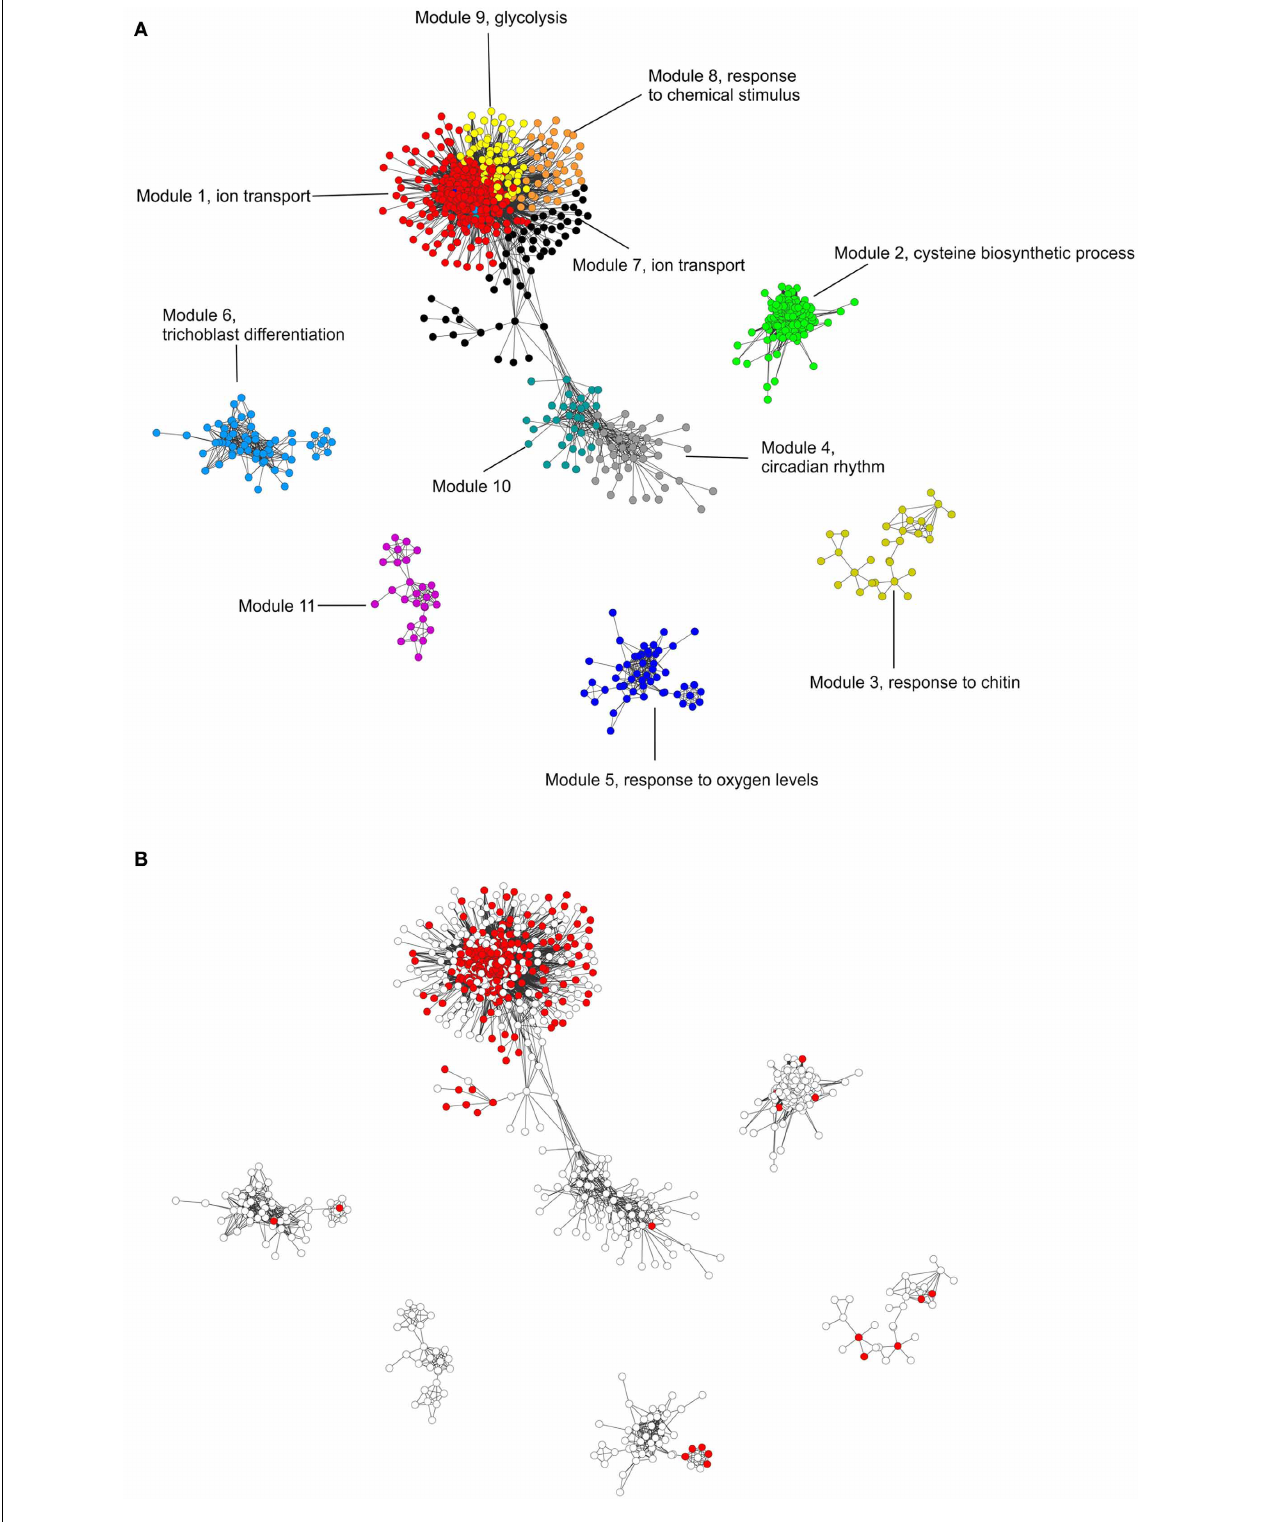
FIGURE 3 | Nitrate-responsive gene coexpression network. (A) Colors are used to distinguish each gene network module. The most over-represented and consistent biological process GO terms (appear in at least 14 different experiments) are indicated in each module ( File S2 ).